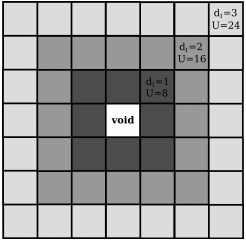
Figure 3. The 8 d I support pixels around a void